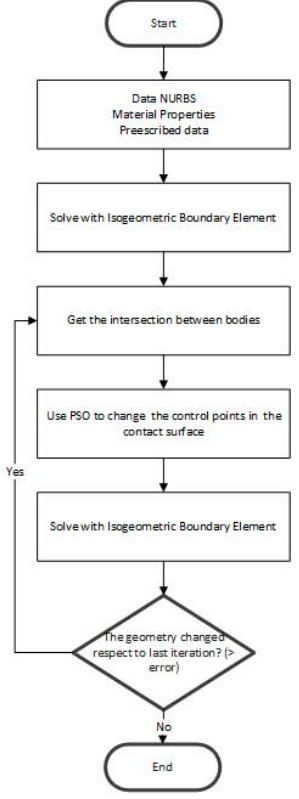
Figure 5. Flowchart to analyze contact with the proposed IGA-BEM.